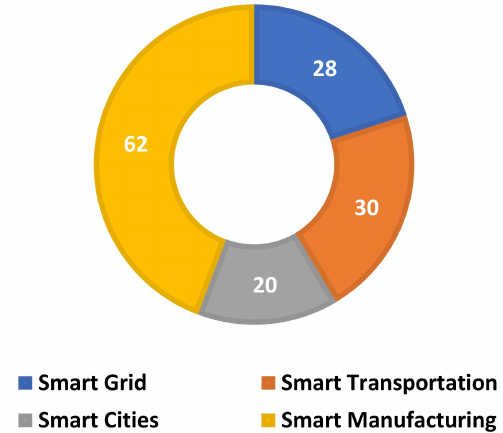
Figure 6. Number of publications related to DT and CPS in IEEE